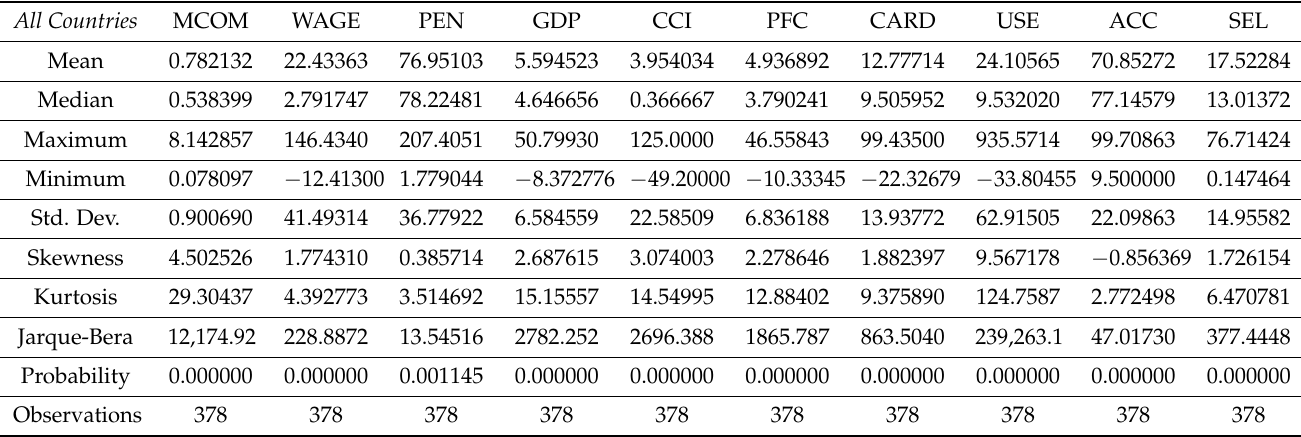
Table A1. Descriptive analyses of 42